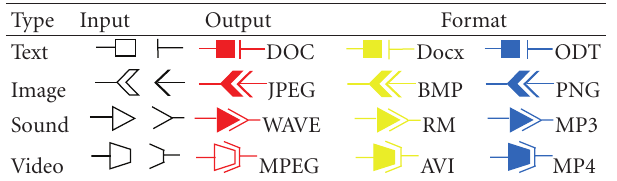
Table 2: Port of multimedia